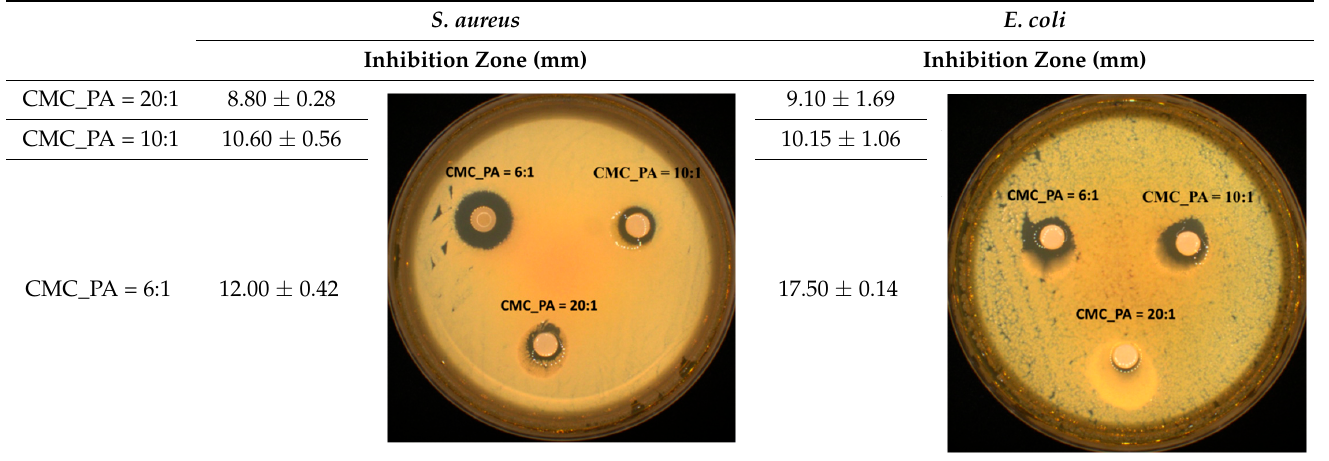
Table 4. Antimicrobial activity of the tested CMC/PA hydrogels against reference strains (mm). S. aureus